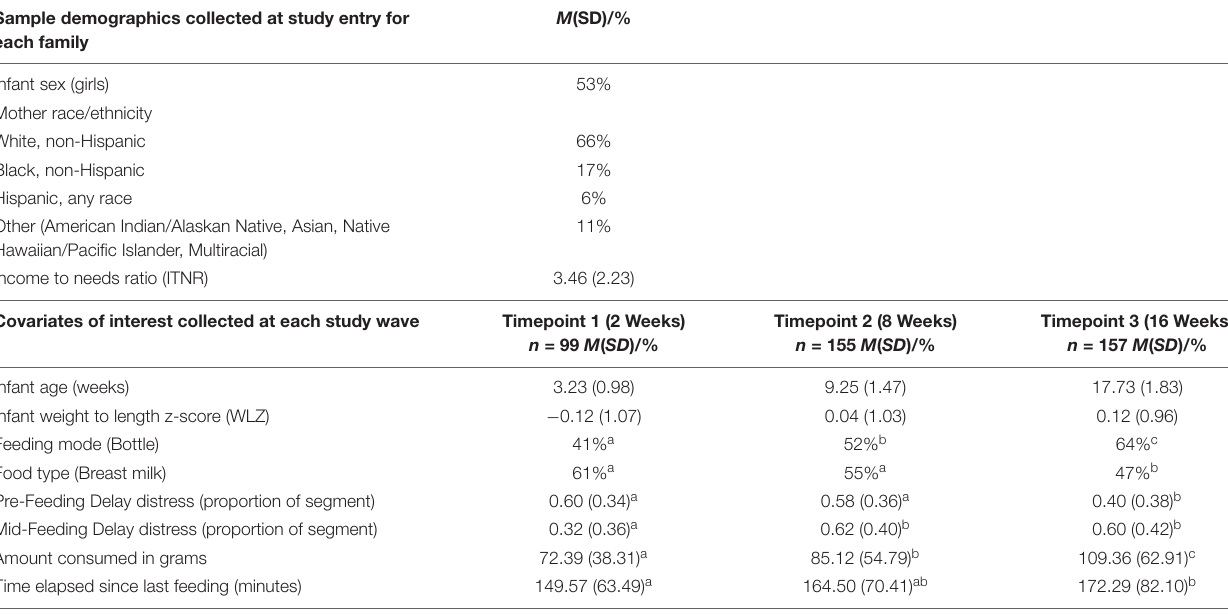
TABLE 3 | Sample demographics and covariates of interest ( N =